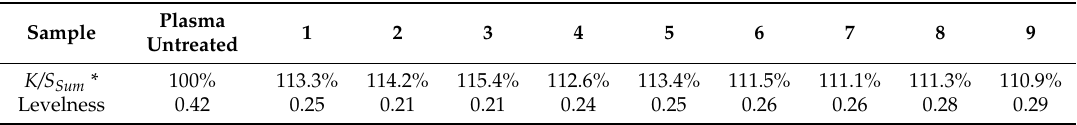
Table 3. K / S Sum values and levelness of pigment dyed cotton fabric (the results were measured with 5%